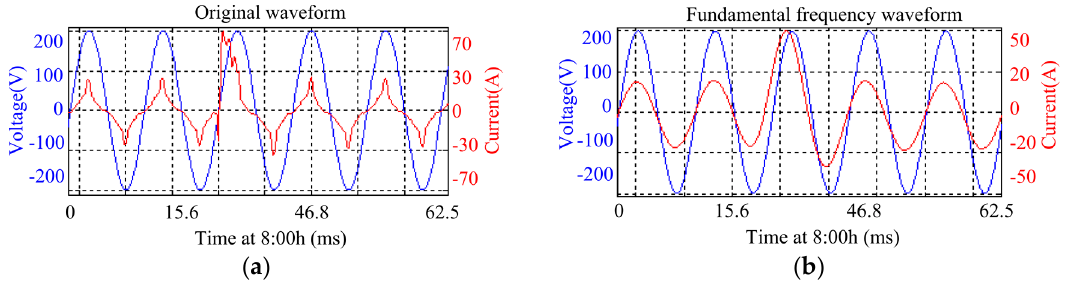
Figure 13. Secondary board SB3.1.1 voltage and current signals at a time when transient PQDs are present: ( a ) original signals; and ( b ) filtered signals around the fundamental frequency.